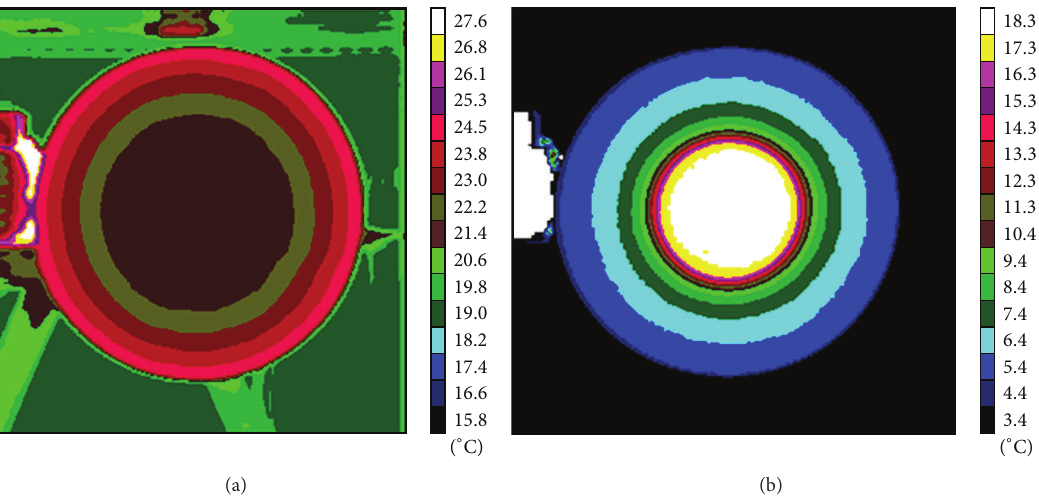
Figure 5: Disk rotating at 4390 rpm: (a) adiabatic wall temperature 𝑇 515 W / m 2